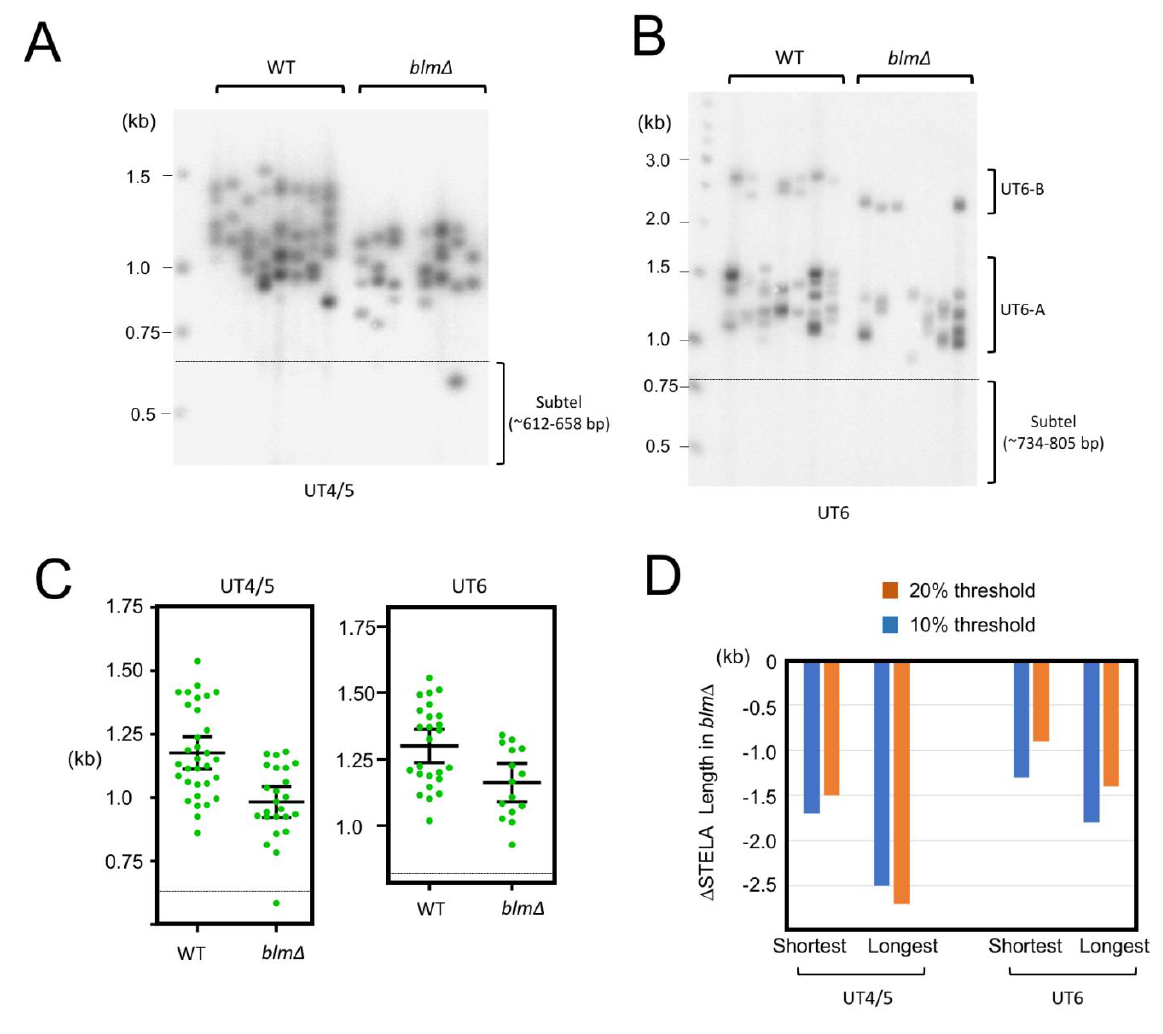
FIGURE 3: STELA comparison of telomeres in the wild type and blm ∆ strains. (A) UT4/5 STELA assays were performed in parallel using wild type and blm ∆ DNA. (B) UT6 STELA assays were performed in parallel using wild type and blm ∆ DNA. (C) The STELA products in 3A and 3B were analyzed using the TESLA software, and the results plotted. Error bars designate standard errors of mean. (D) The telomere threshold lengths that mark the upper (or lower) quintile (20%) or decile (10%) of telomeres from the rest were determined for the vari- ous STELA samples. The reductions in the threshold lengths in blm ∆ relative to wild type samples are then